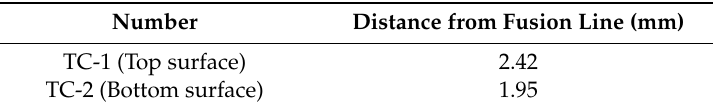
Table 3. Locations of K-type